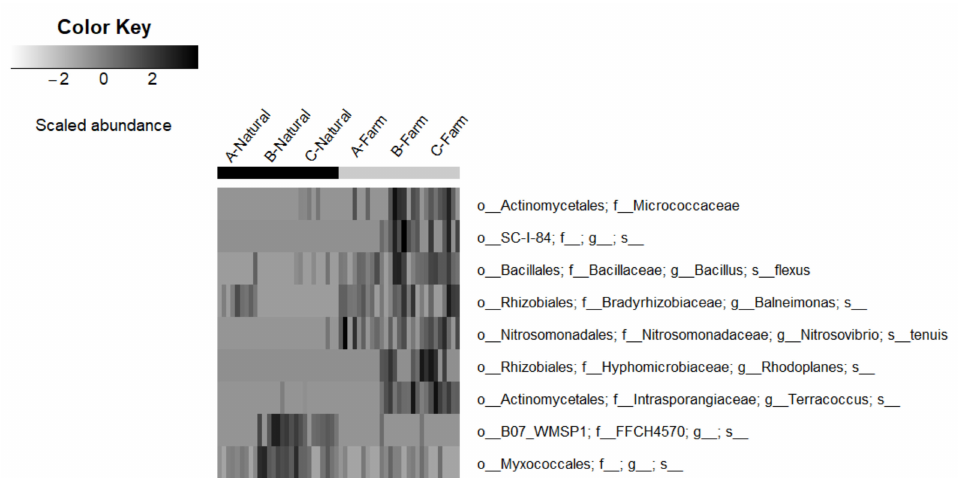
Figure 4. Heatmap of the OTUs significantly abundant in each land-use. All OTUs were tested by mvabund on R, and OTUs with significantly larger relative abundances in each land-uses were plotted in the figure. The heatmap was created by scaling the abundances of the OTUs and colored by the scaled abundances.